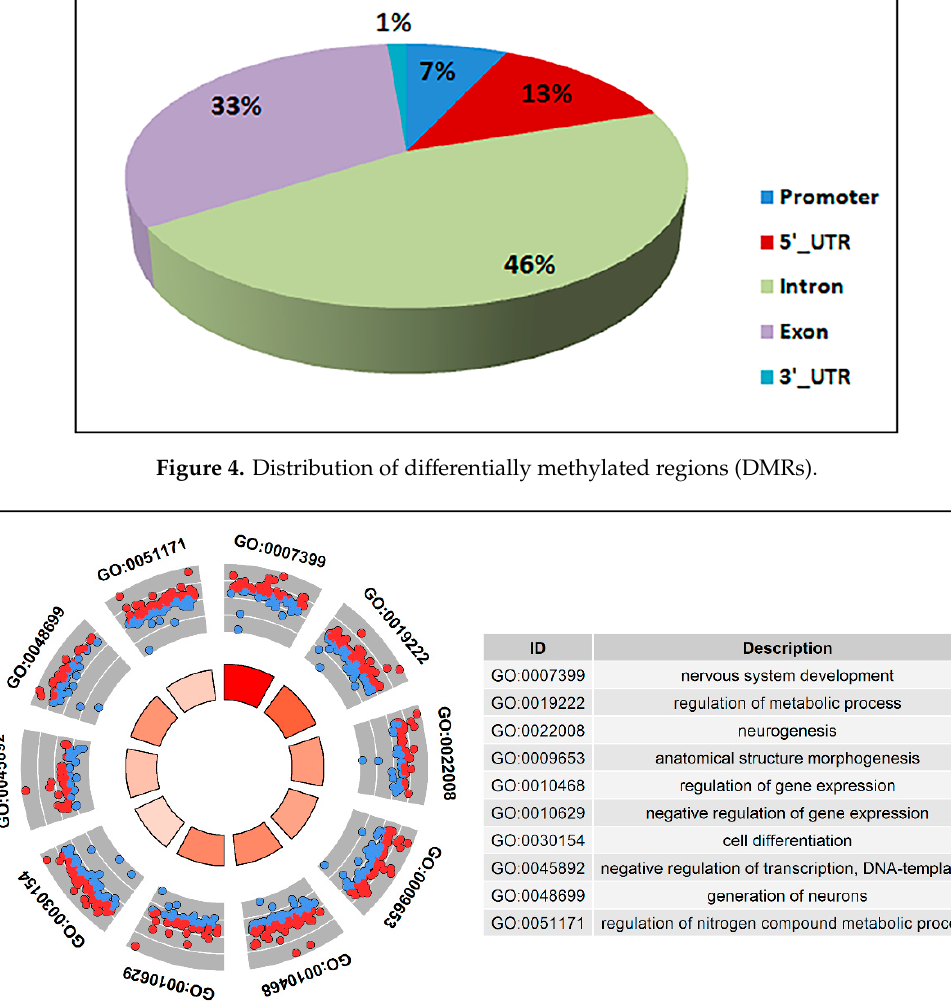
Figure 4. Distribution of differentially methylated regions (DMRs).